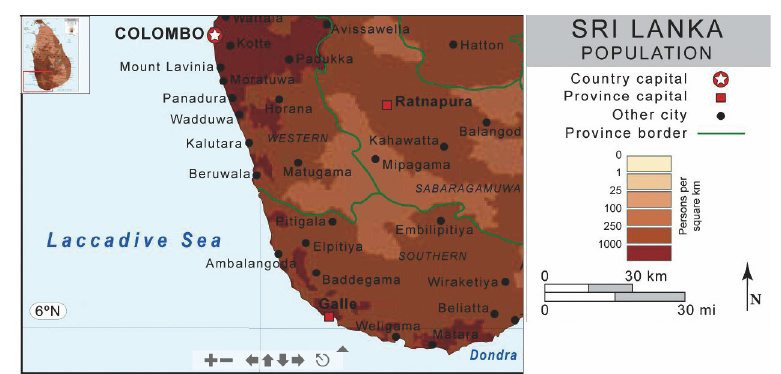
Fig. 4. Population distribution in Sri Lanka presented using a choropleth map without borders of administrative units, which are also the base units (source: http://www.stockmapagency.com/Population_Map_Sri%20Lanka - _C-SriL-2007-Pop.php